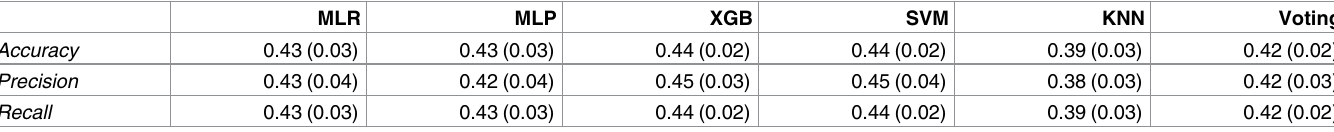
Table 4. Classification performance using k -fold cross-validation ( k =